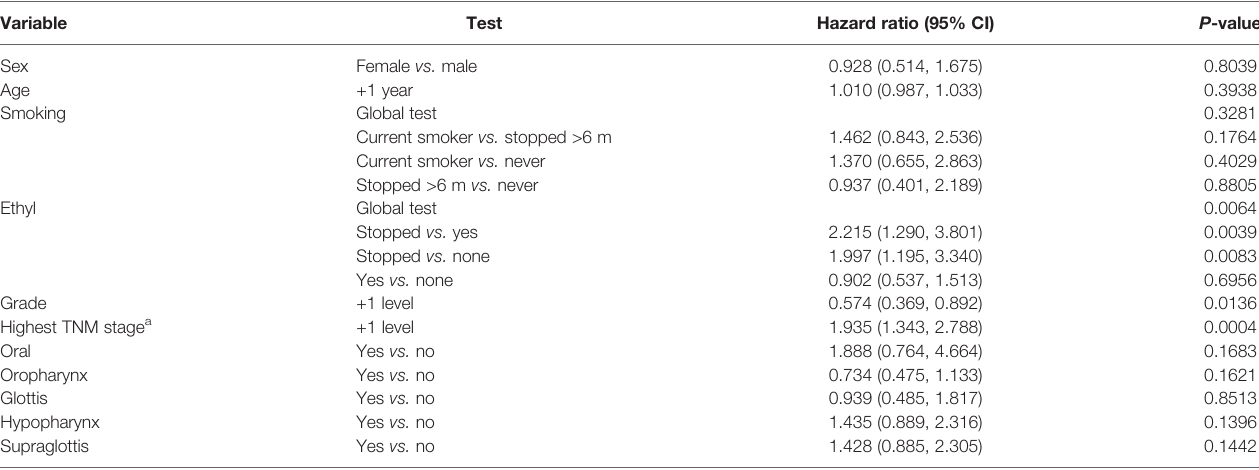
TABLE 2 | Univariate analysis for locoregional recurrence.